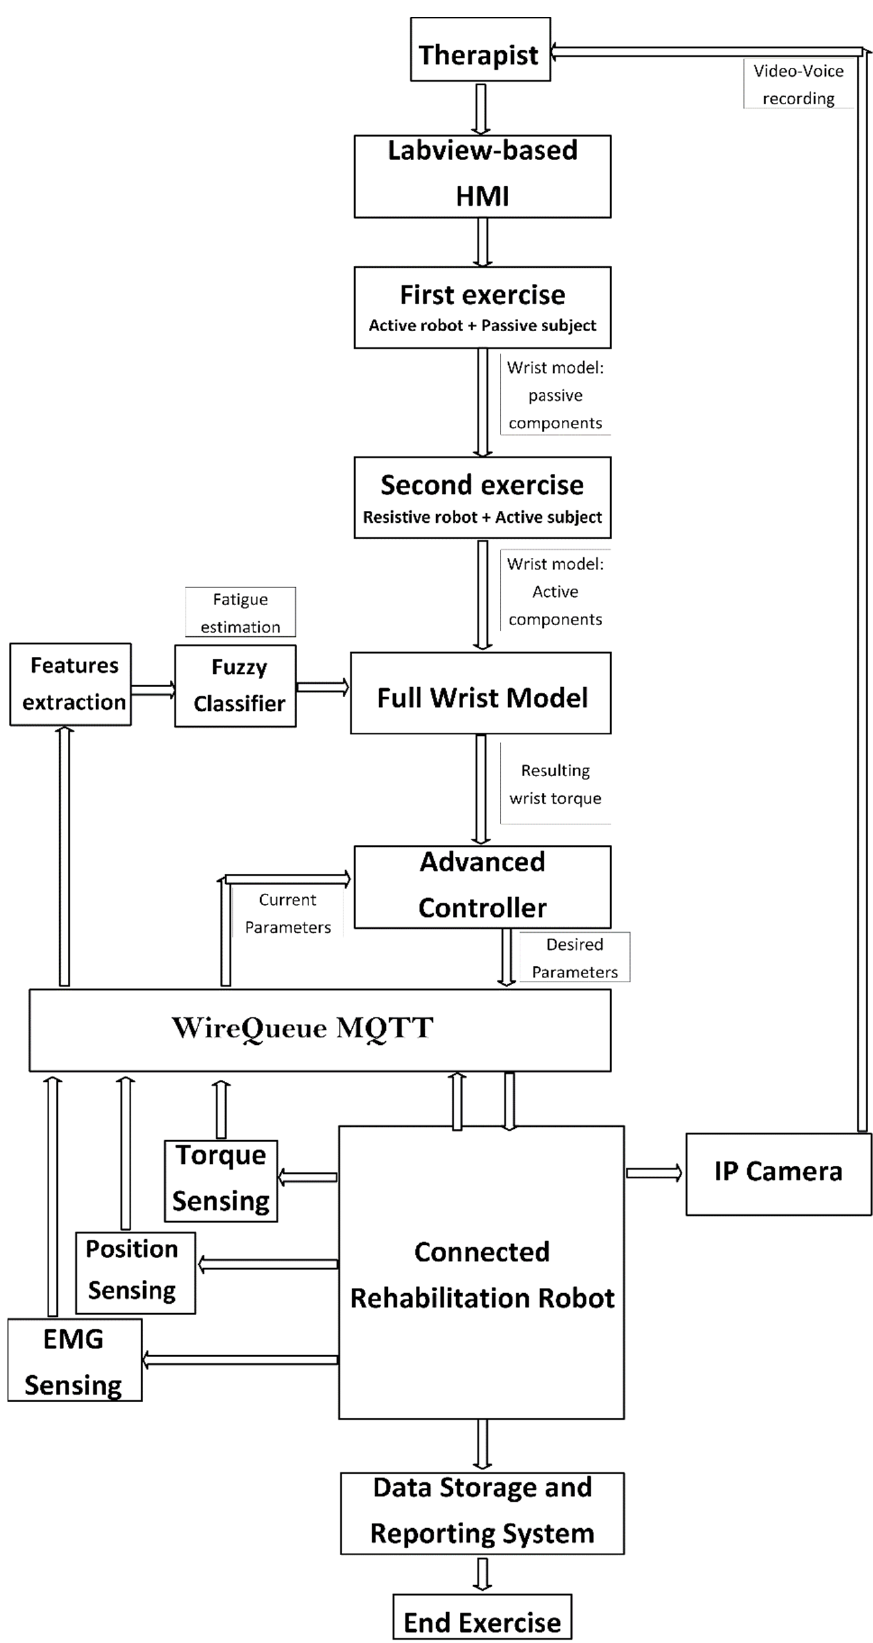
Figure 12. Operating system flowchart.